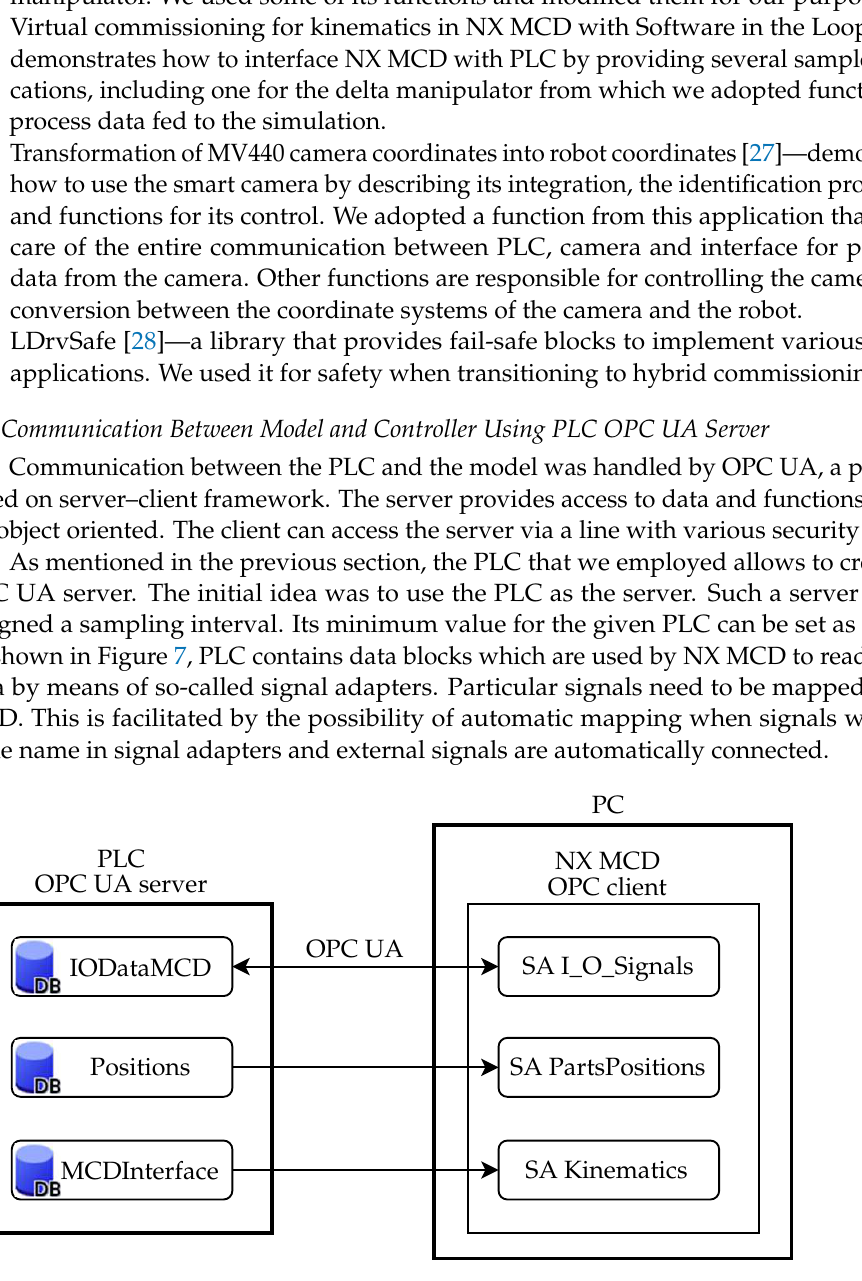
Figure 7. Communication structure between PLC OPC UA server and NX MCD (DB – data block, SA – signal adapter.)